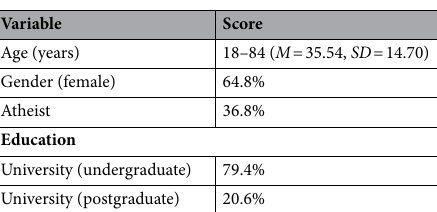
Table 3. Sample characteristics for the confirmatory factor analysis ( n = 248).